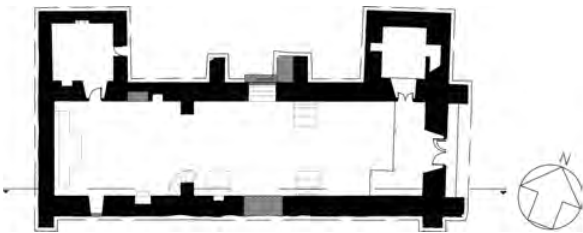
Figure 3. Identification of conditions using visual inspection